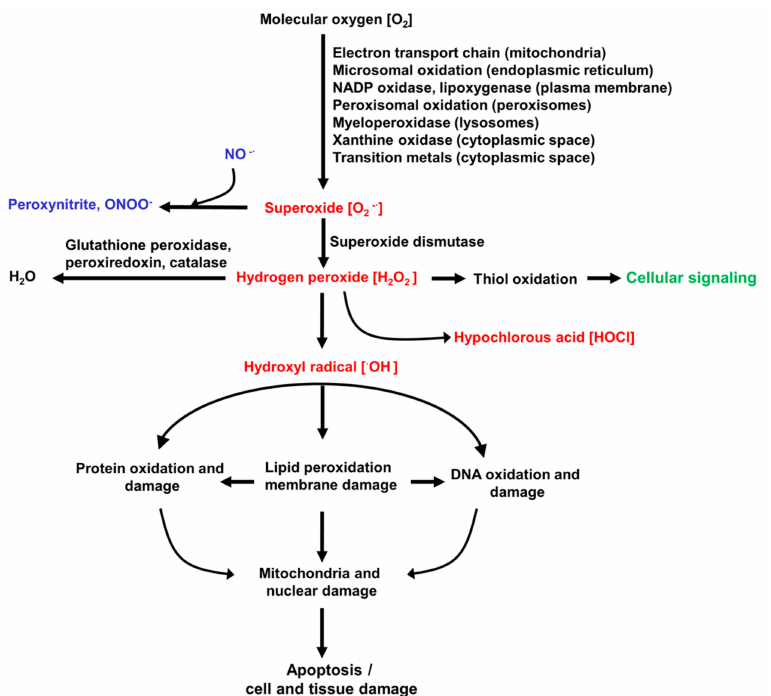
Figure 1. Reactive oxygen species (ROS) involved in liver disease. Shown are the main ROS (in red), the pathways for their formation, and a schematic indication of the downstream damage to proteins, DNA, and organelles that can potentially be caused by ROS. Under normal conditions (non-oxidative stress), H 2 O 2 also has important intracellular signalling functions (indicated in green). Superoxide can also generate reactive nitrogen species (indicated in blue), which contribute to cellular